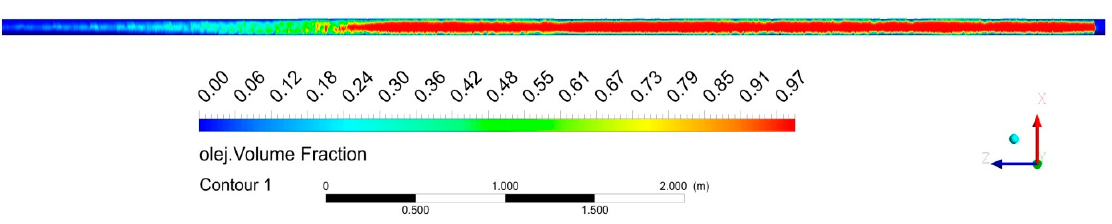
Figure 9. Volume of the oil at the surface of the pipe over its full length at the speed of 5 m/s with a pipe diameter of 15 mm.